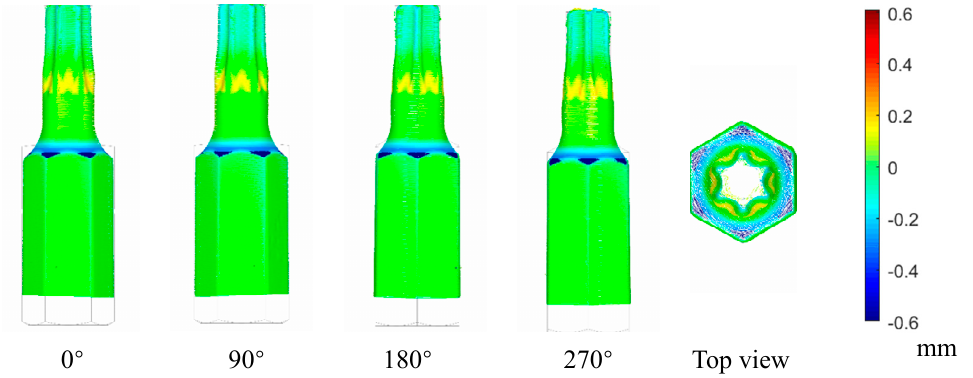
Figure 15. The best alignment result histograms. ( a ) Deviation distribution of alignment result; ( b ) RMS distribution of alignment result.